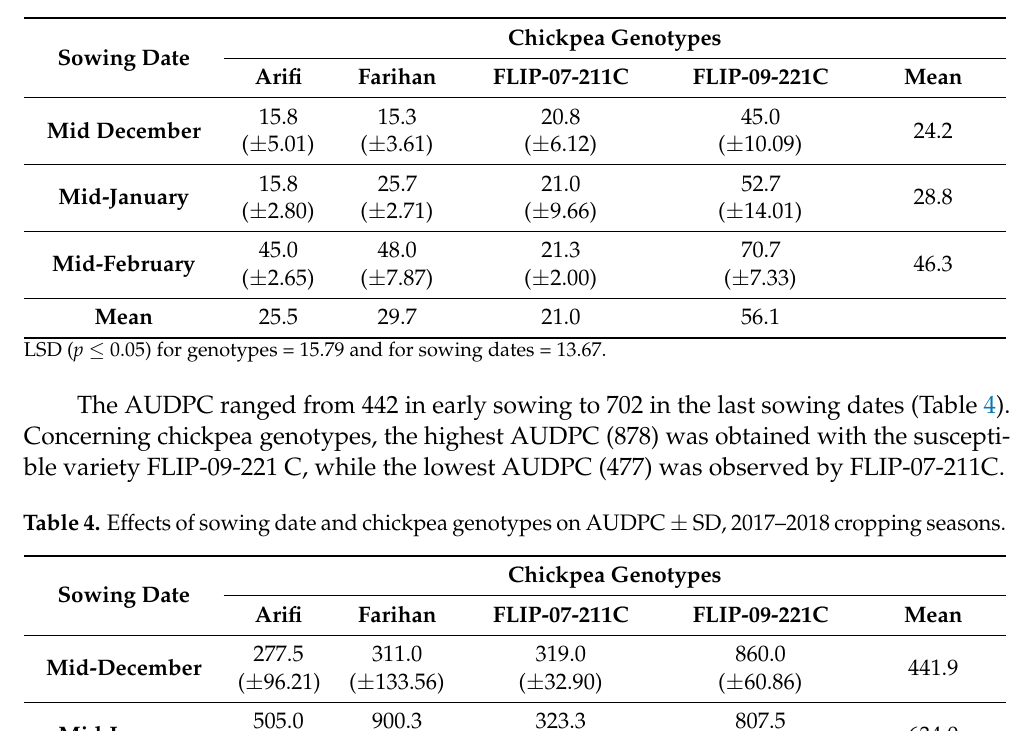
Figure 3. Partial view naturally of the field experiment at Merchocuh Research station, 2018. Table 3. Effects of sowing date and chickpea genotypes on mean percent final Fusarium wilt incidence ± SD, 2017–2018 cropping seasons.